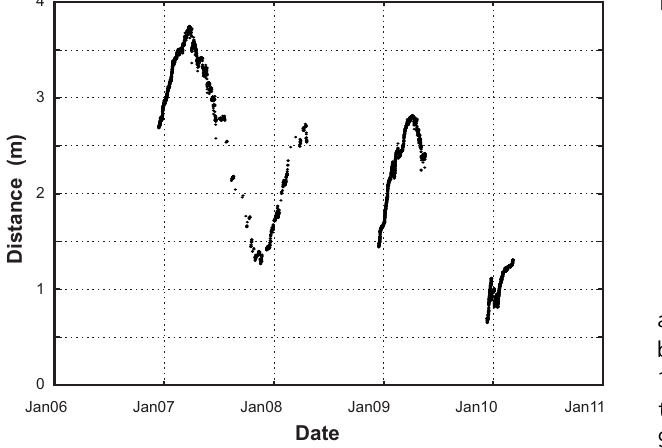
Fig. 4. Distance to snow surface registered by the ultra-sonic ranger.